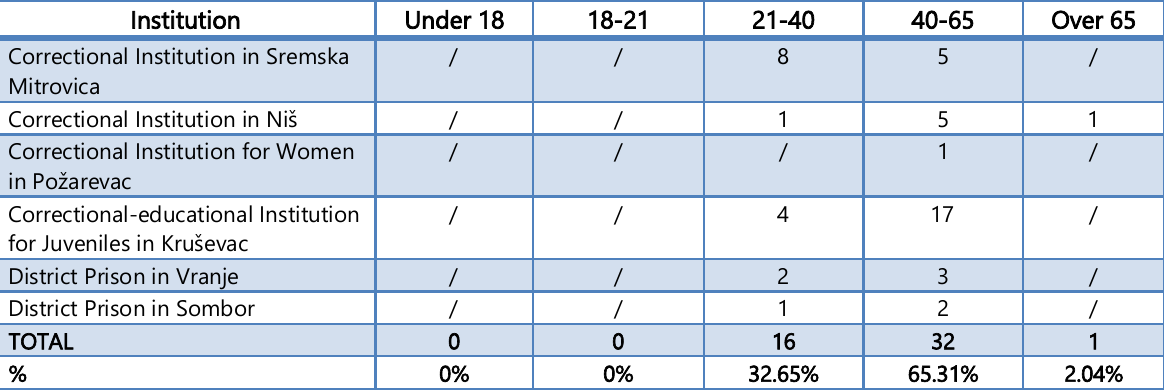
Table 3: Age of Interviewed Persons – Employees (Source: Author‟s depiction)